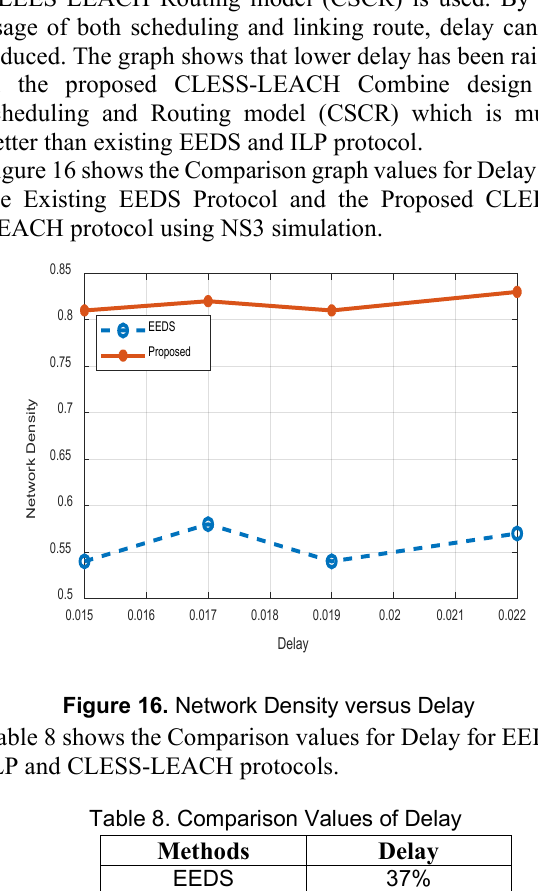
Table 7. Comparison Values of Latency